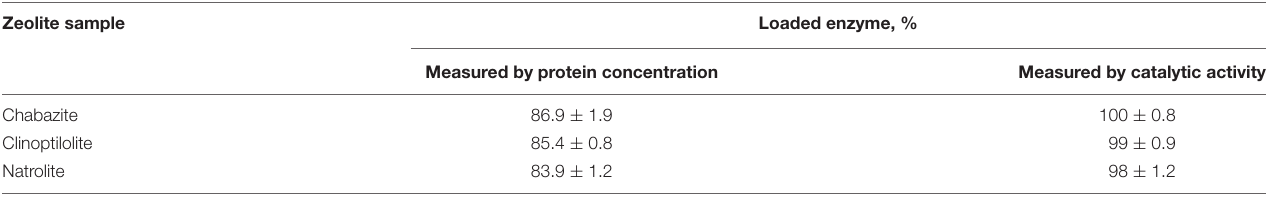
TABLE 1 | The amount of binase loaded onto zeolite and silica samples from ethanol solution a . Zeolite sample